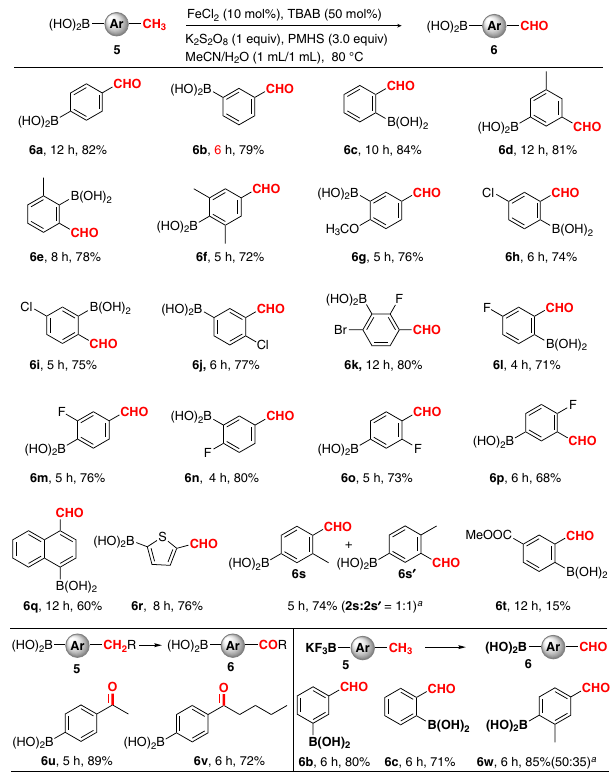
Fig. 3 Substrate scope. The substrate scope of alkyl arylboronic acids and potassium methyl aryltri fl uoroborates. Reaction conditions: substrate 5 (0.25 mmol), FeCl 2 (10 mol%), TBAB (50 mol%), K 2 S 2 O 8 (0.25 mmol), PMHS (0.75 mmol), CH 3 CN/H 2 O (1:1, 2.0 mL), 80 °C, and air; yields of